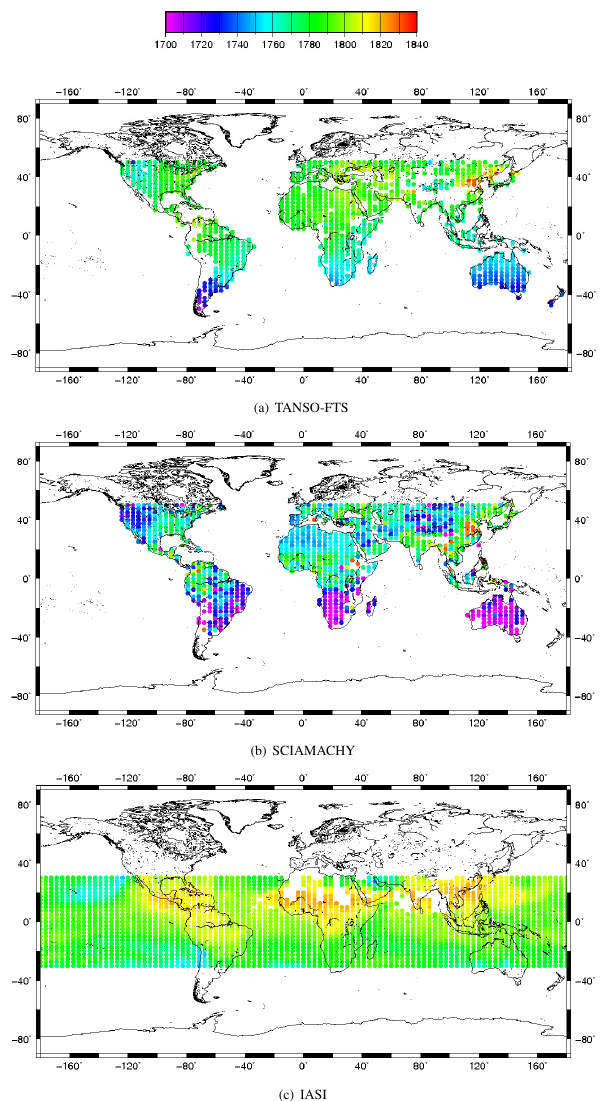
25 Fig. 2. Satellite “super-observations” (ppb) used in the inversions Fig. 2. Satellite ”super-observations” ( ppb ) used in the inversions for the month of July 2010. for the month of July 2010.